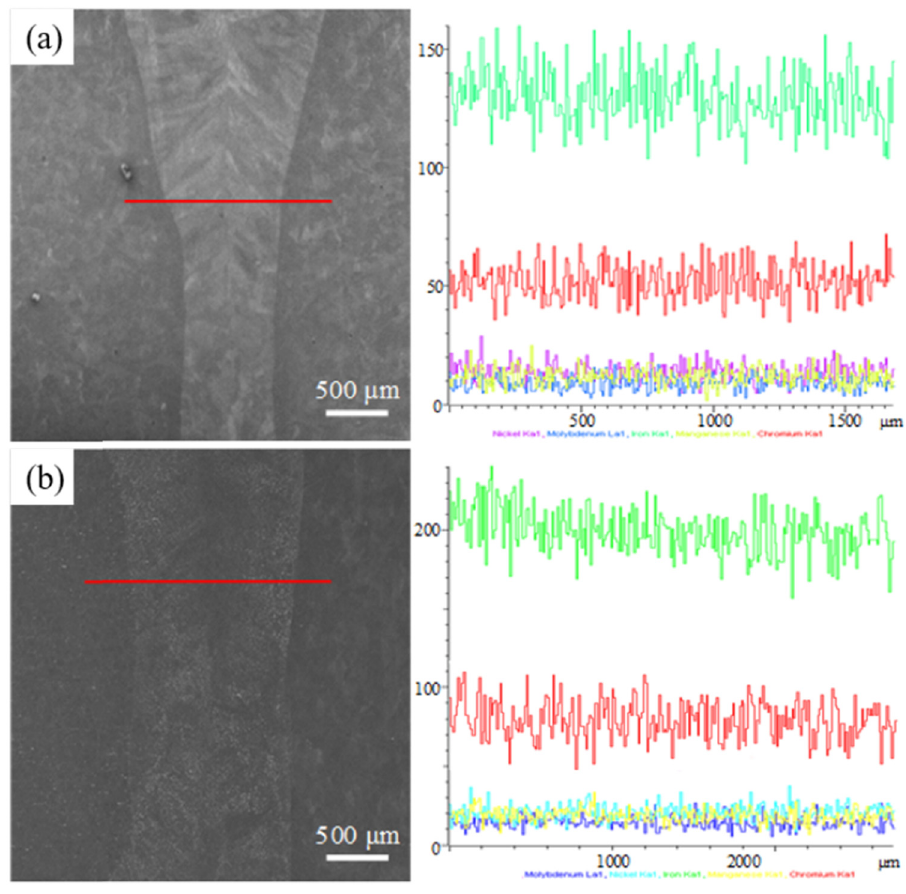
Figure 6: Line map of ( a ) AW joint and ( b ) ST joint.